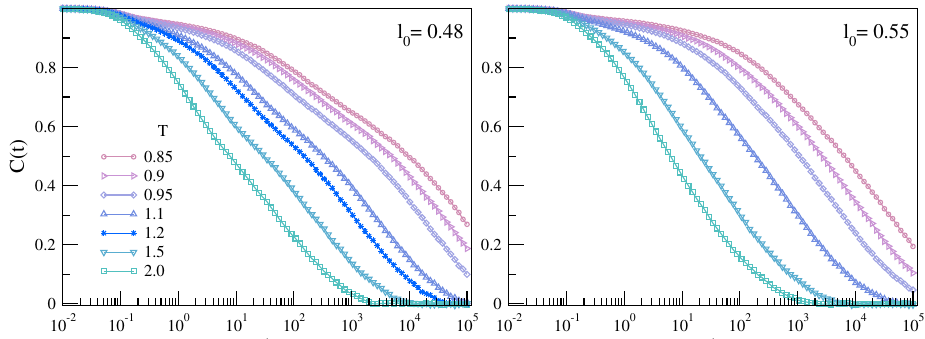
Figure 9. Temperature dependence of the BCF of the chains with different bond lengths. If l 0 = 0.48, a two-step decay–evidencing two distinct relaxations–is observed. We ascribed the faster one to the JG β relaxation and the slower one to the structural α relaxation [25,26]. The data were taken from Reference